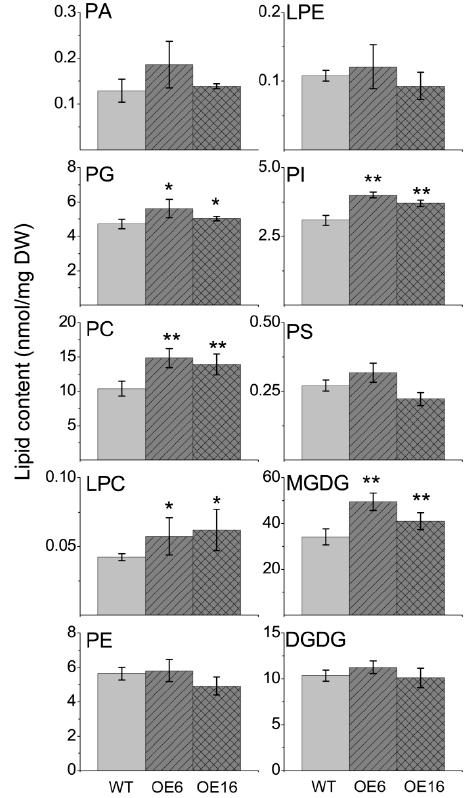
Figure 4. Effect of BnATS1 -overexpression on membrane lipids. Lipids were extracted from leaves of 40-day-old plants under field growth conditions. Values are means ± SD ( n = 4 separate samples). * and ** denote significance at p < 0.05 and p < 0.01, respectively, compared with WT plants based on Student’s t test. PA, phosphatidic acid; PG, phosphatidylglycerol; PC, phosphatidylcholine; LPC, lysophosphatidylcholine; PE, phosphatidylethanolamine; LPE, lysophosphatidylethanolamine; PI, phosphatidylinositol; PS, phosphatidylserine; MGDG, monogalactosyldiacylglycerol; DGDG,